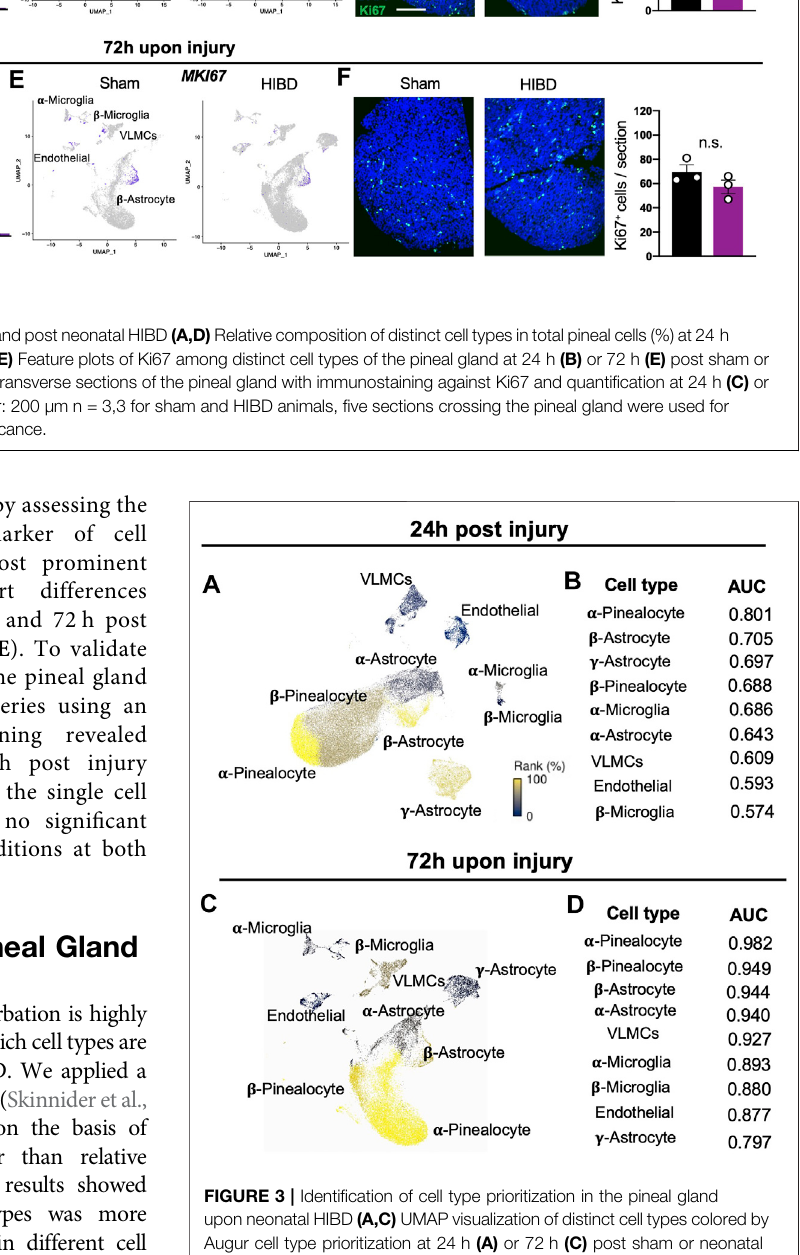
Frontiers in Cell and Developmental Biology |